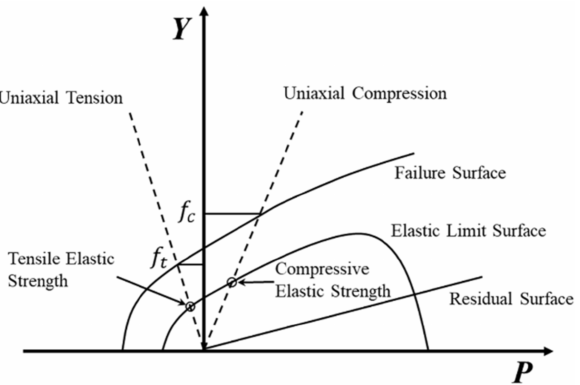
Figure 13. Maximum strength, yield strength, and residual strength